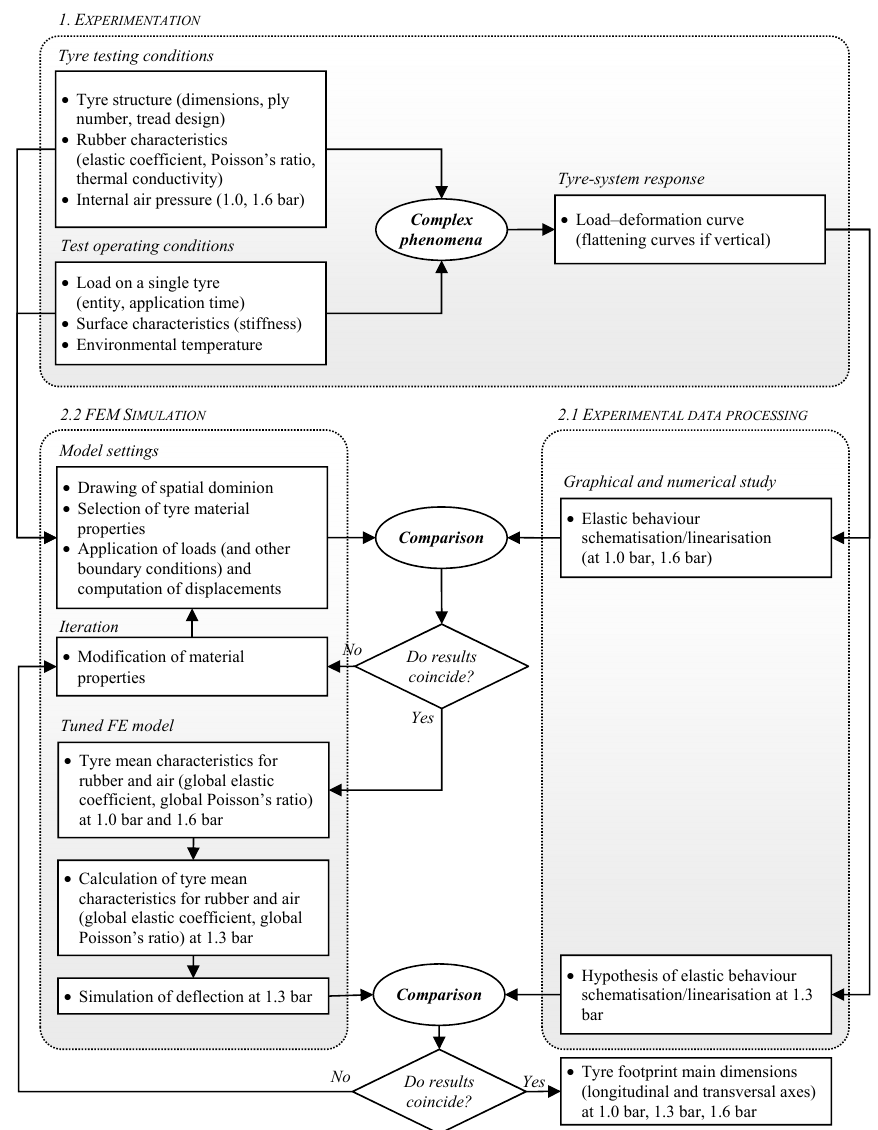
Figure 1. Approach followed for the computation of the mean characteristics for the schematisation of a tyre (including the concurrent behaviour of rubber and